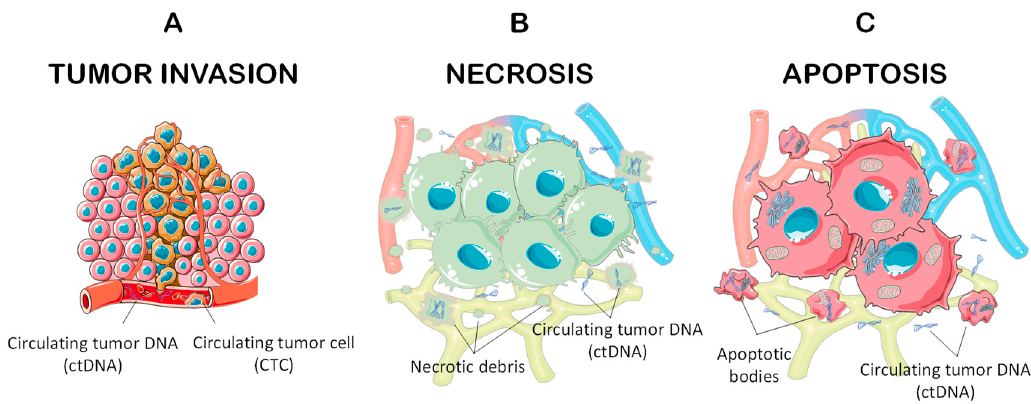
Figure 1. Release modalities of circulating tumor DNA (ctDNA) and circulating tumor cells (CTCs). ( A ) Invasive tumors release CTCs and ctDNA directly in the tumor infiltrating vessels or in invaded arteries and veins; ( B ) Necrotic cells release ctDNA directly into the cellular interstitium that reach the bloodstream through the lymphatic vessels; ( C ) Similarly, apoptotic cells release ctDNA directly in the cellular interstitium or through apoptotic